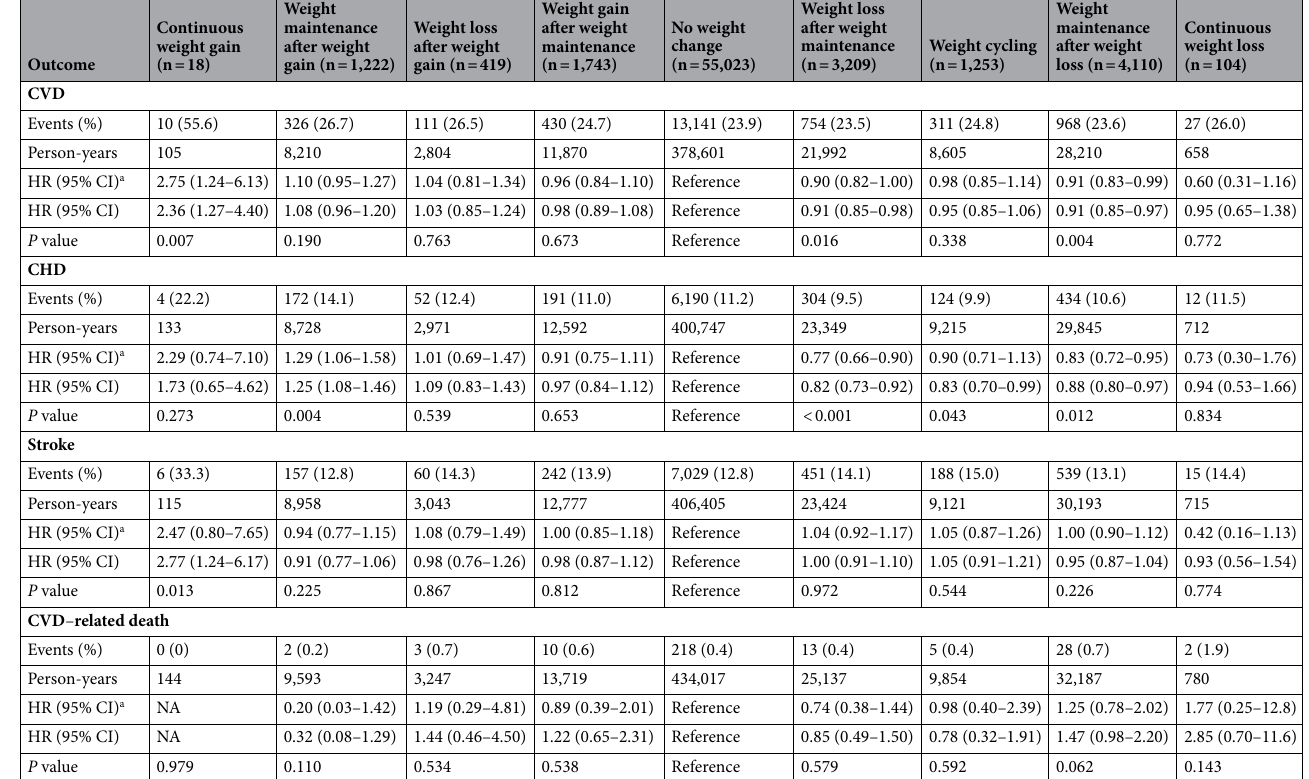
Table 2. Effects of body mass index maintenance status at third period health examination on risk of cardiovascular disease, coronary heart disease, stroke, and cardiovascular disease-related death. HR calculated by Cox proportional hazards regression analysis after adjustments for age, sex, household income, initial body mass index, systolic blood pressure, fasting serum glucose, total cholesterol, aspartate aminotransferase, Charlson comorbidity index, smoking, alcohol consumption, and exercise frequency. a 3 years of latent period washed out for sensitivity analysis. Acronyms: CVD, cardiovascular disease; HR, hazard ratio; CI, confidence interval; CHD, coronary heart disease; NA, not